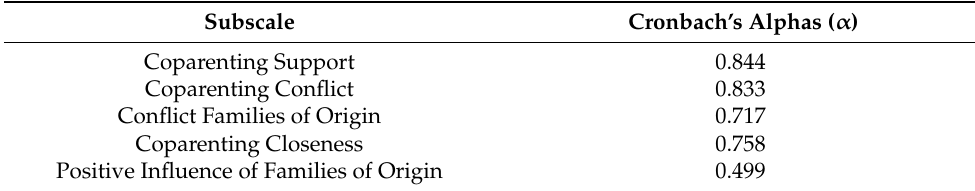
Table 3. Internal Consistency of Lack of Coparenting Support; Coparenting Conflict; Conflict Families of Origin; Coparenting Closeness; Positive of Influence of Families of Origin among Heterosexual